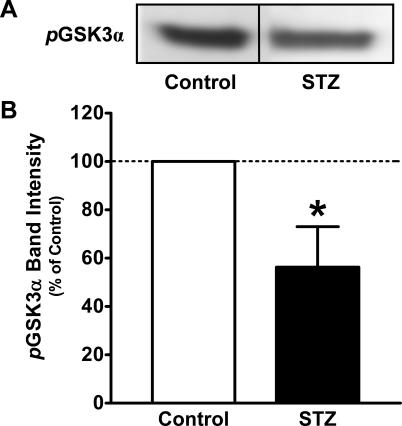
STZ Decreases Akt Activity in Rat Striatum(A) Representative immunoblots for phosphorylated GSK3α (pGSK3α), a downstream target of Akt, in either untreated subjects (control) or in those that received STZ 1 wk before sacrificing the animals.(B) Quantitation of pGSK3α immunoreactivity conducted in striatal synaptosomes 7 d after STZ (65 mg/kg, intravenous [i.v.]). The densities of the pGSK3α bands were normalized to their respective total protein concentrations (determined by protein assay; 100 μg) and then expressed as a percentage of control. *p < 0.05, paired Students t-test (n = 3).